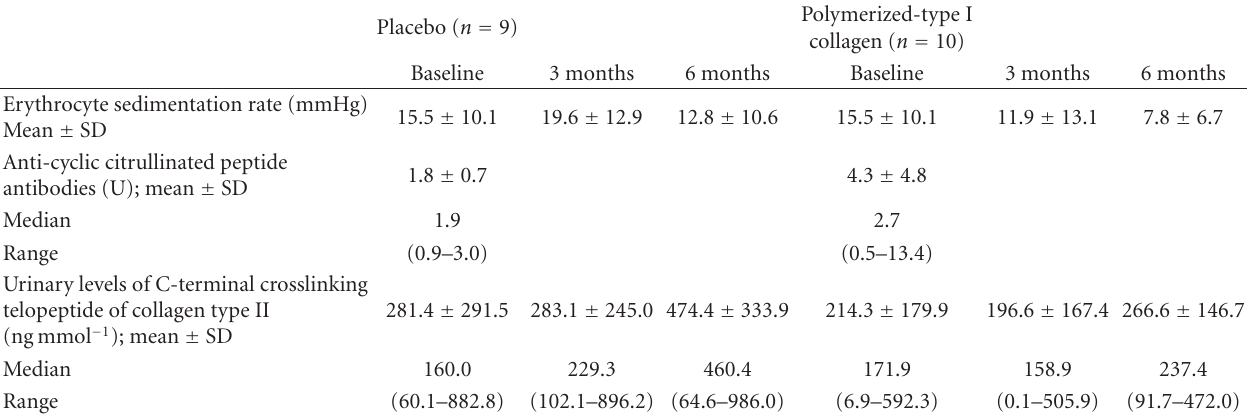
Table 3: Laboratory characteristics of the